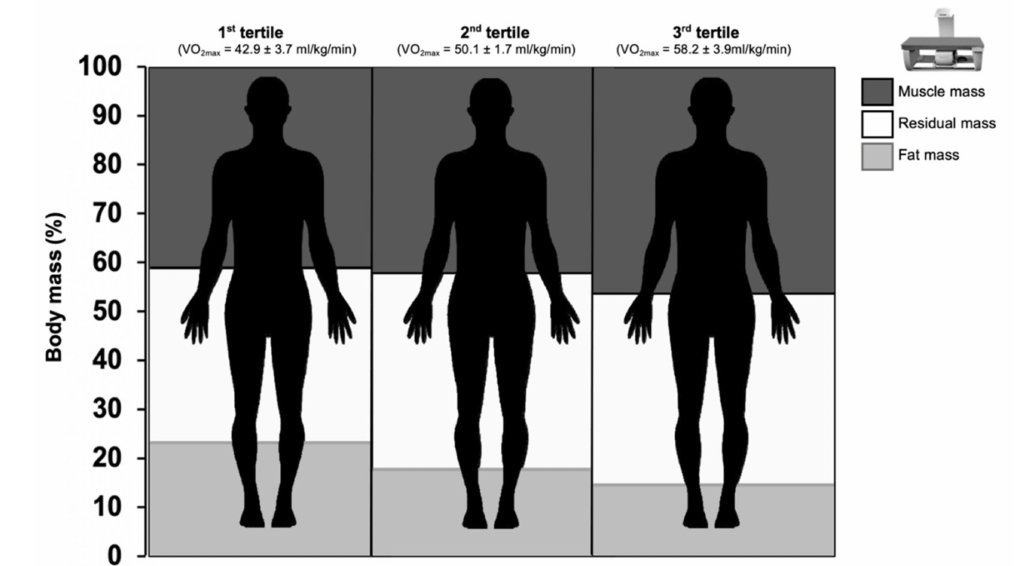
Figure 2. Body composition assessed with DXA according to the three-compartments tissue model in the futsal players grouped by tertiles of VO 2max